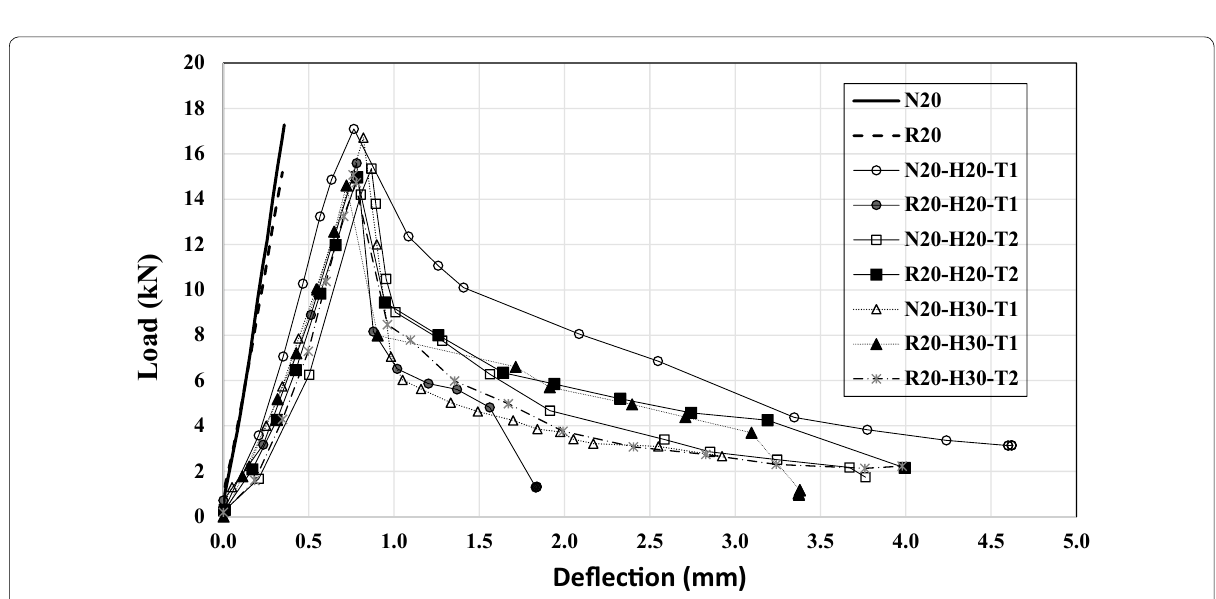
Fig. 8 Load-deflection curves of the standard beams; Group 2, MSA